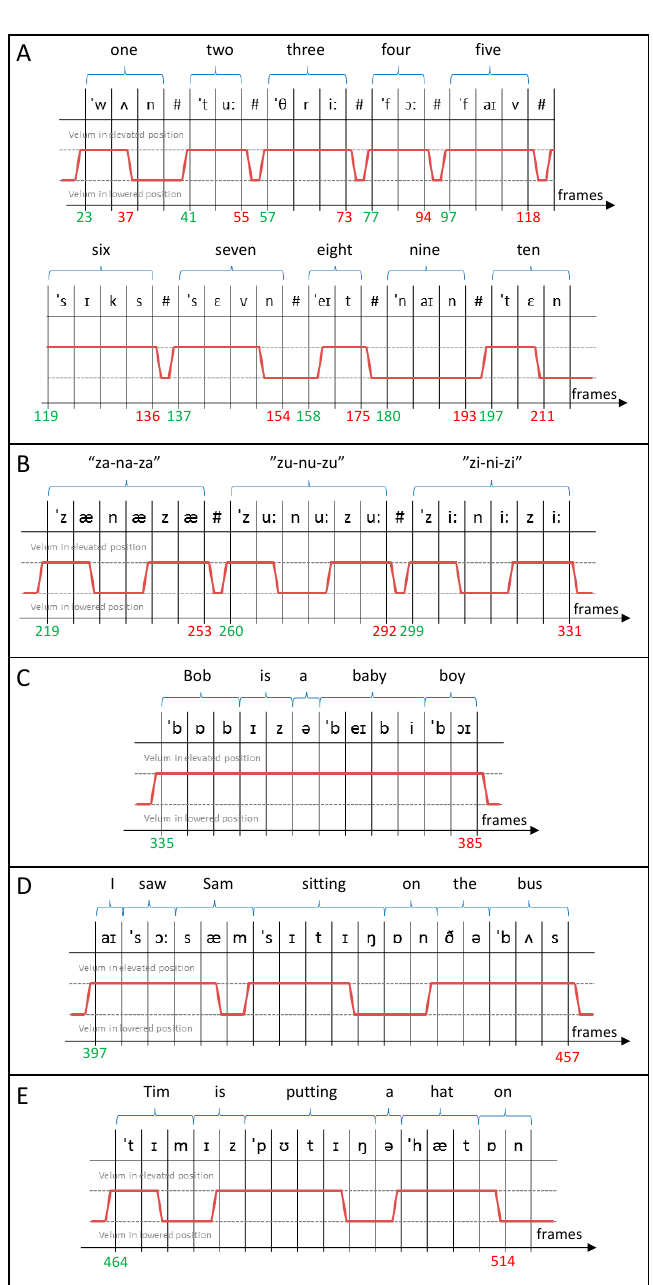
Figure 8. Details of the speech sample used in the numerical simulation including counting ( A ), non-sense phonation ( B ) and sentences ( C – E ). For each part of the speech sample, the phonetics sounds are included along with the position of the velum (red line) and the starting (green) and ending (red) frame number.